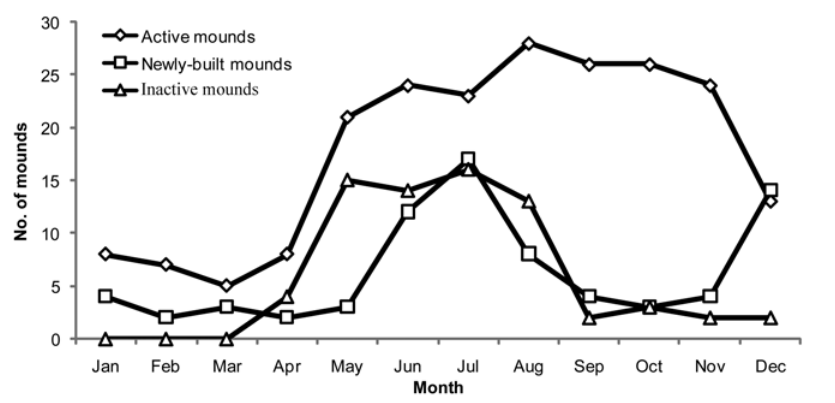
Fig. 1 Annual dynamics of of S. invicta